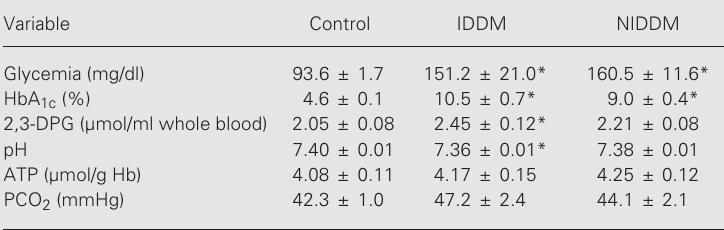
Table 3. Comparison of blood variables of the studied